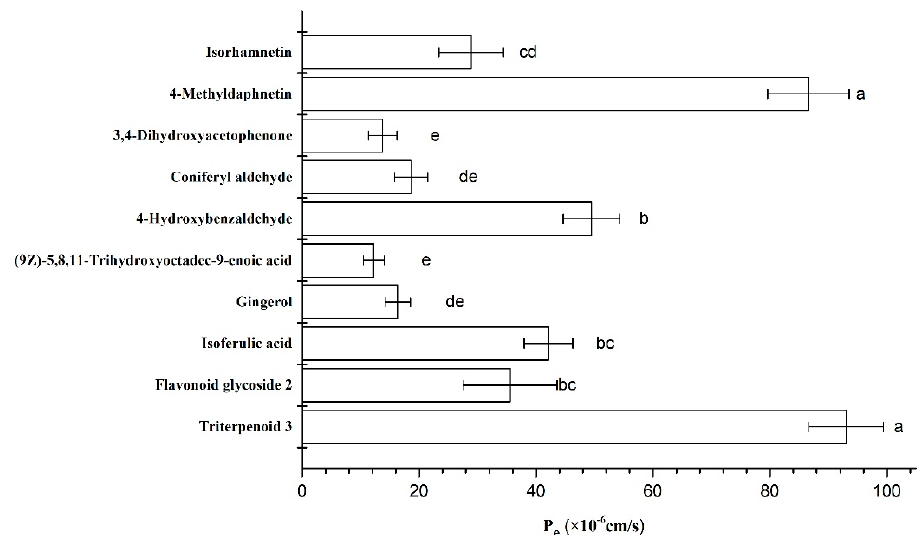
Figure 3. Permeability P e ( × 10 − 6 cm/s) of compounds in the thinned peach extracts. Different letters next to the error bars indicate significant differences between compounds after ANOVA with Tukey’s post hoc test, p -value < 0.05.